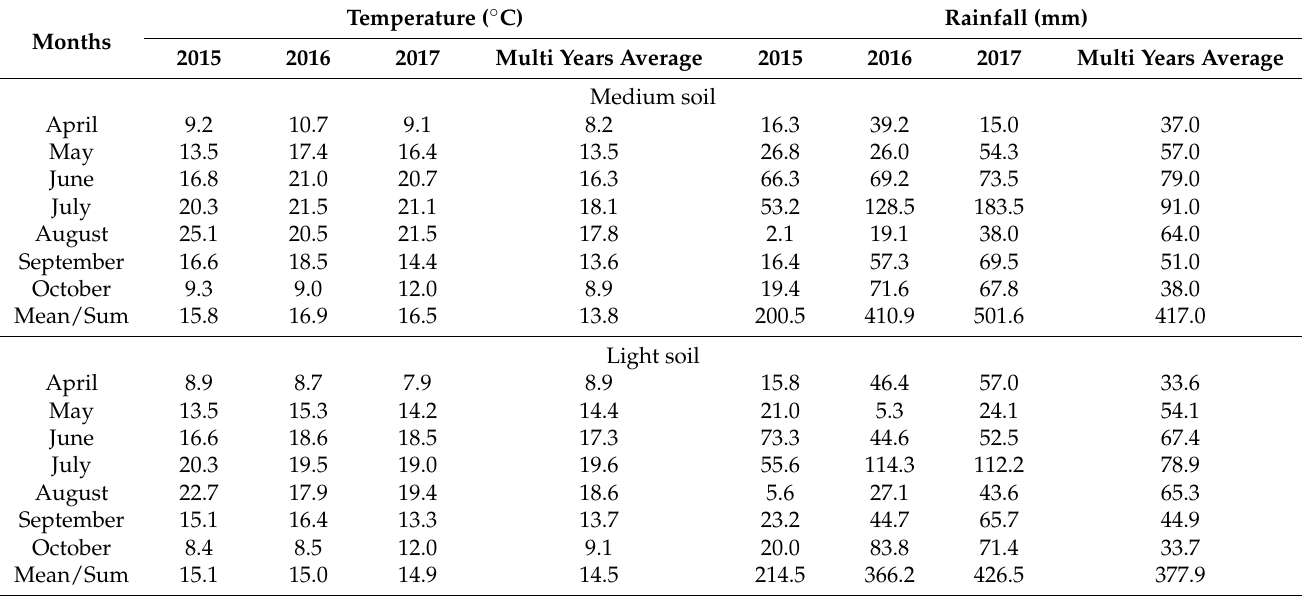
Table 3. Average temperature ( ◦ C) and rainfall sum (mm) for quinoa vegetation